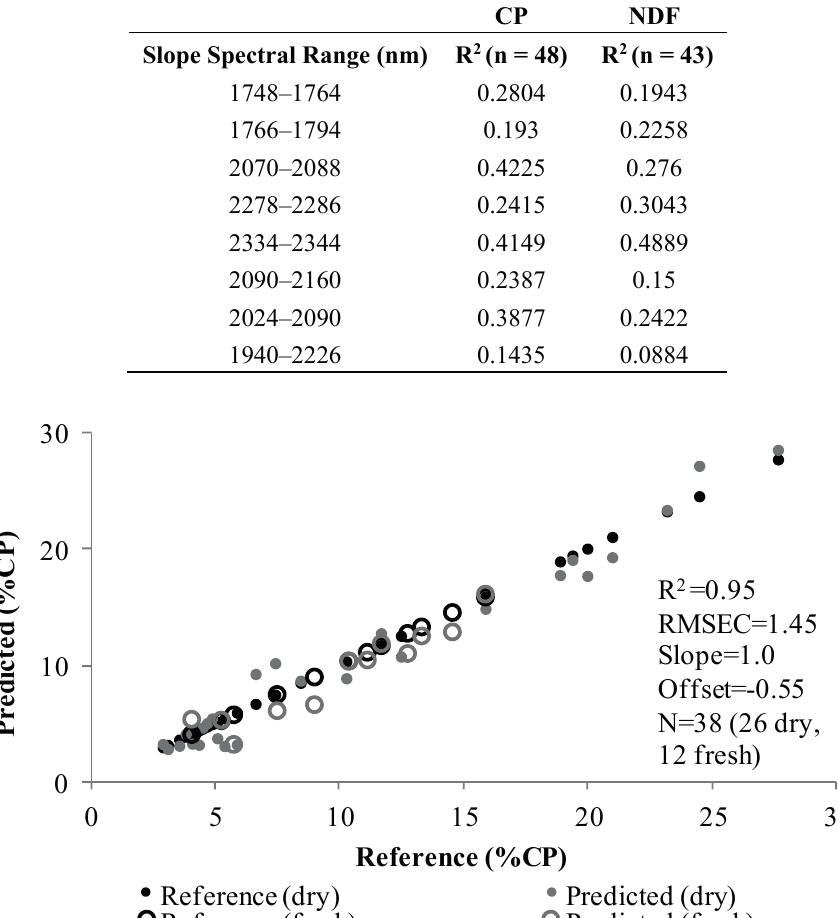
Table 1. Correlation between slopes in selected spectral regions and crude protein (CP) and neutral detergent fiber (NDF) contents of fresh vegetation.